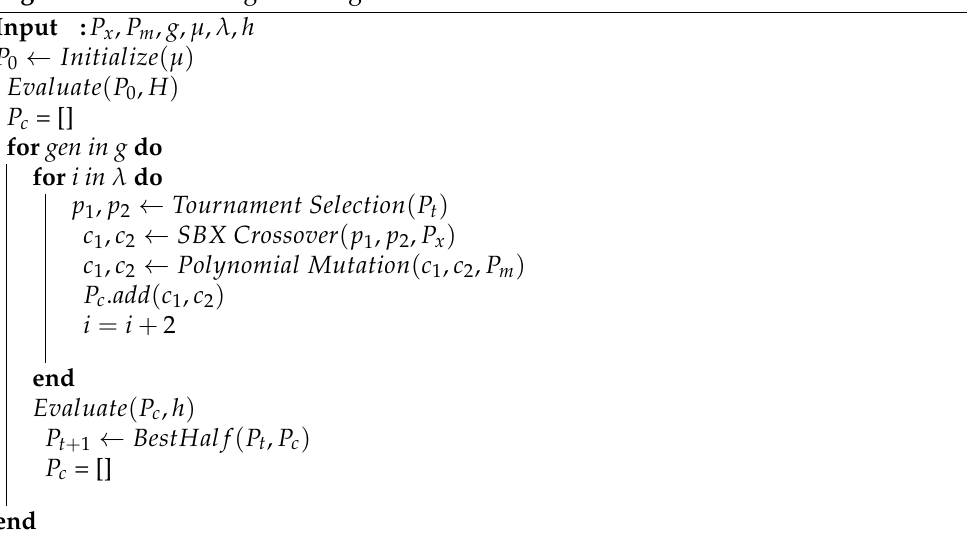
Algorithm 1 An elitist genetic